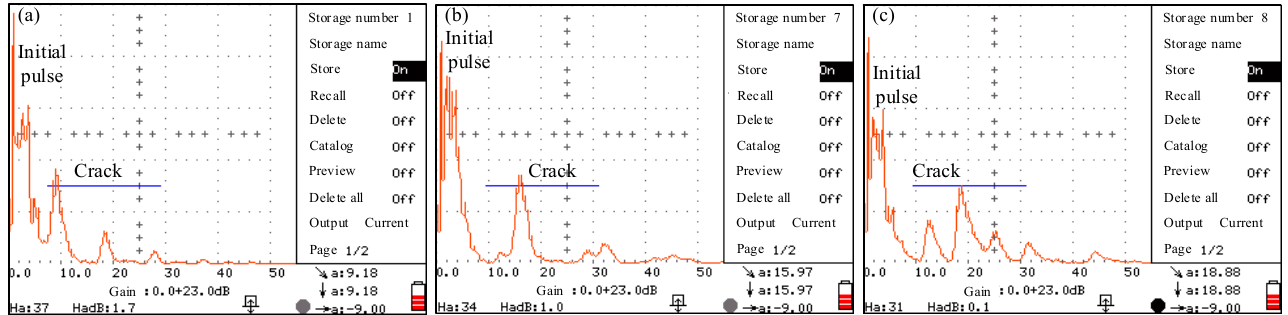
Figure 11. Ultrasonic crack testing results of shear studs of specimen S-2 after 890,000 loading cycles in the fatigue test: ( a ) stud No. 1; ( b ) stud No. 7; ( c ) stud No. 8.